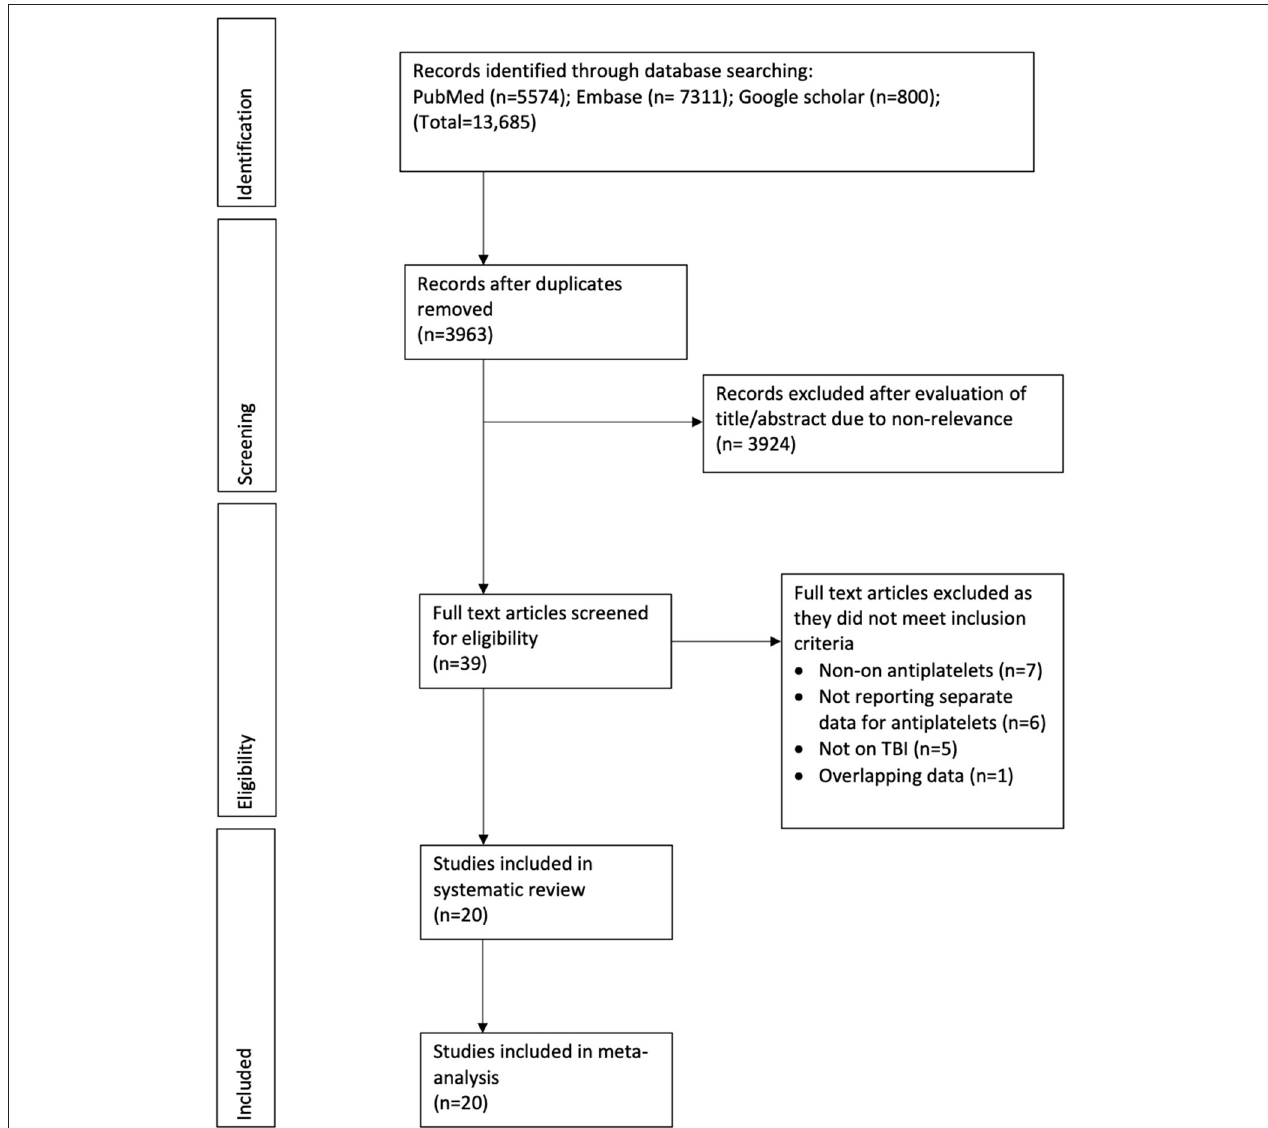
FIGURE 1 | Study flow